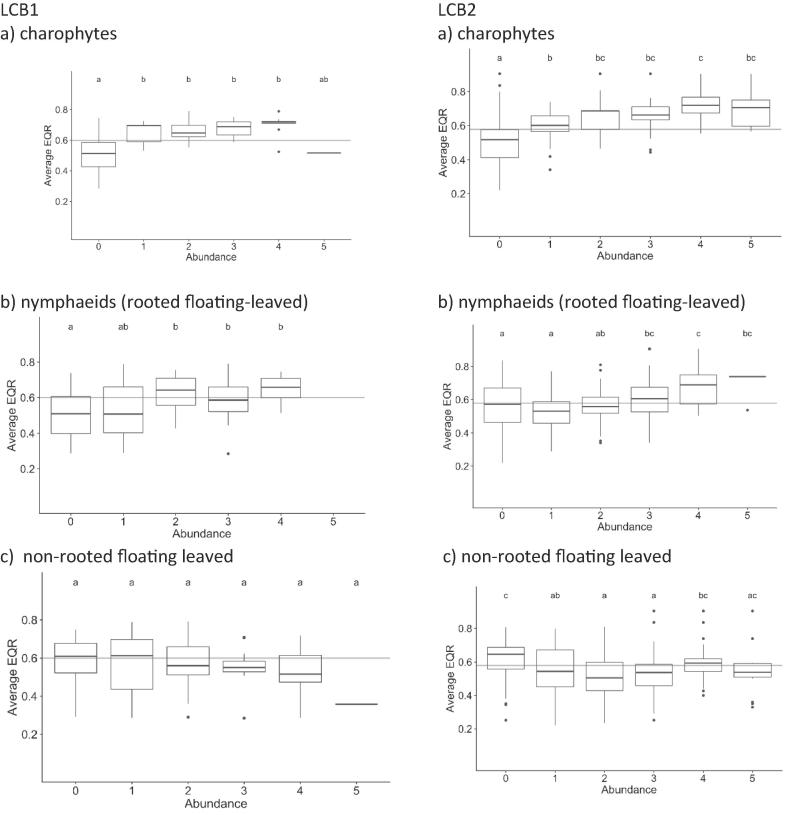
Box plot showing the relationship between EQRavg and growth forms: charophytes (a), nymphaeids (b) and floating plants (c) for LCB1 (left) and LCB2 (right). Different letters indicate abundance classes that are statistically different (p ≤ 0.05). The horizontal line separates ‘good’ and ‘high’ status from ‘less than good’ status.